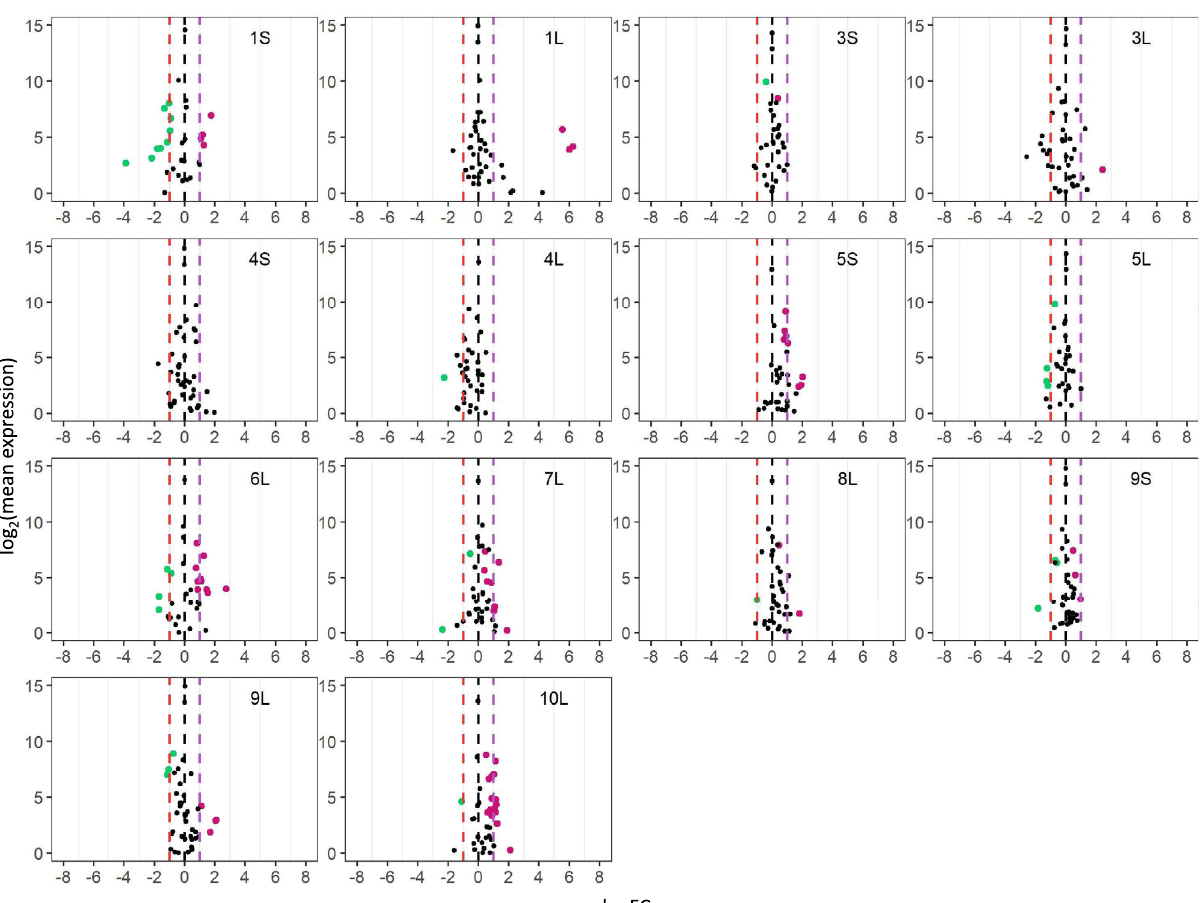
Fig. 2 Scatter plots of trans MIRNA expression in each monosomy compared with diploids (1D/2D). The x-axis represents the log fold change with base 2 of each experimental genotype to the control, whereas the y-axis notes the log 2 value of the mean of normalized counts of each experimental genotype and the control. Data points with an FDR < 0.05 and a corresponding logFC > 0 were depicted in magenta, while points with an FDR < 0.05 and a corresponding logFC < 0 were depicted in green. Otherwise, they were painted in black. A fold change (FC) of 1.0 (logFC of 0) represents no change. An FC of 2.0 represents the inverse ratio of MIRNA expression in trans , whereas 0.5 represents a positive modulation. These FC values are demarcated with labeled vertical lines in red (0.5), black (0), and purple (2.0). Source data are provided in Supplementary Data in Fig. 6a and Supplementary Data 3, with the disomies (h2D/ h1D) and monosomies (1D/2D) bearing a greater number of